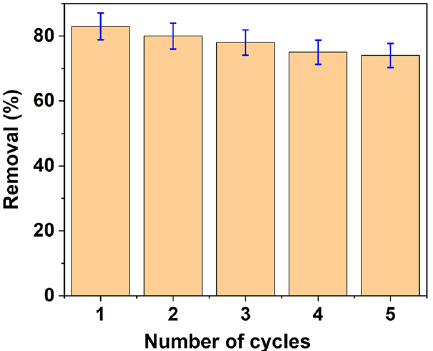
Fig. 11 The equilibrium adsorption isotherm curves for 30 mg/L RhB (50 mL) adsorbed on L-Asp capped Fe 3 O 4 (1 mg/mL) at pH 7 and 25 °C Table 2 The isotherm parameters obtained from the adsorption of RhB onto L-Asp capped Fe 3 O 4 NPs (1 mg mL −1 )